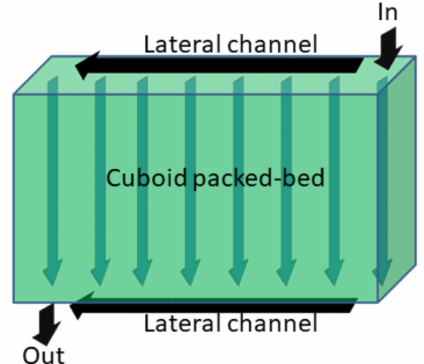
Figure 2. Idealized flow paths in a cuboid